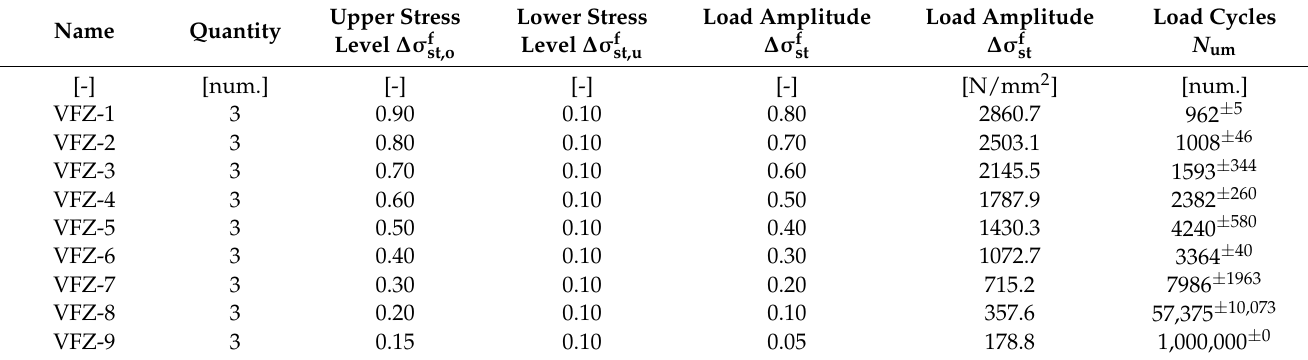
Table 3. Experimental programme of tensile tests subjected to cyclic